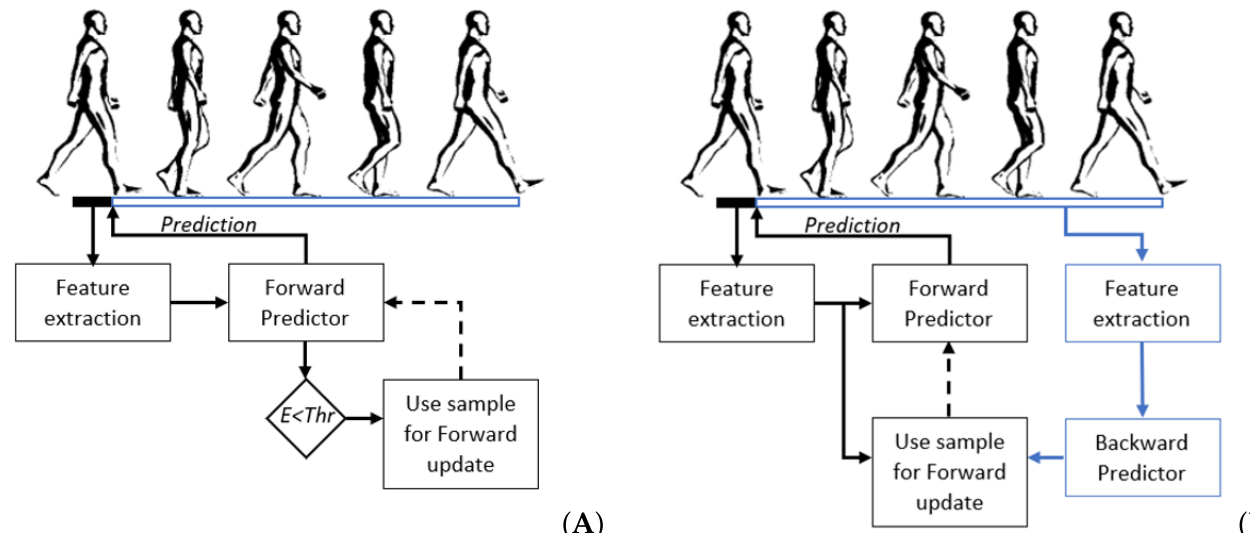
Figure 2. Overview of the adaptation pipelines. ( A ) Entropy based adaptation. First features from a window prior to initial contact were extracted. Hereafter, the forward predictor predicted the upcoming activity. Based on the probability of the forward predictor the entropy (E) is estimated. If the entropy lies below the threshold (Thr) the sample is stored to be used for updating the forward predictor. ( B ) Backward predictor adaptation. The forward prediction works the same as before. After a stride, features were extracted from the previous stride and used by the backward predictor to predict the previous activity. The prediction of the backward predictor was then stored together with the features from the forward prediction to be used for updating the forward